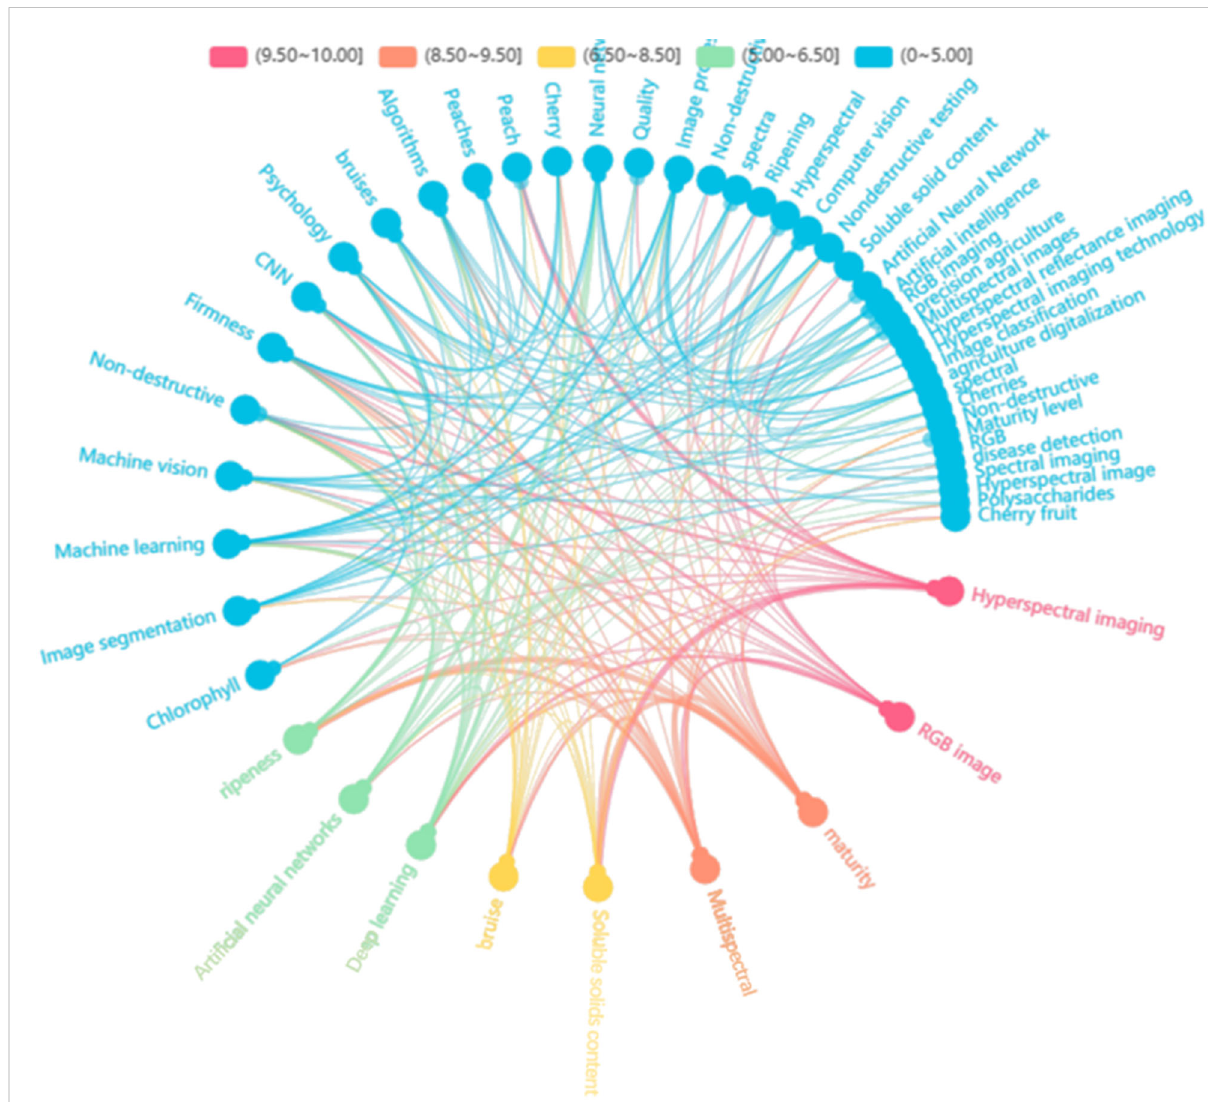
FIGURE 1 Reference keyword frequency distribution